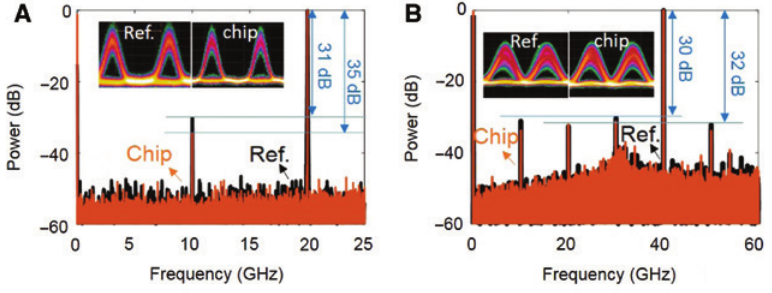
Figure 6: Spectral characteristics of the output clock signals generated using the filter chip and commercial multiplier: (A) for the output at 20 Gpulses/s; (B) for the output at 40 Gpulses/s. Inset: OOK eye diagrams comparison between the outputs of the filter chip and the com- mercial reference when the OSNR = 15